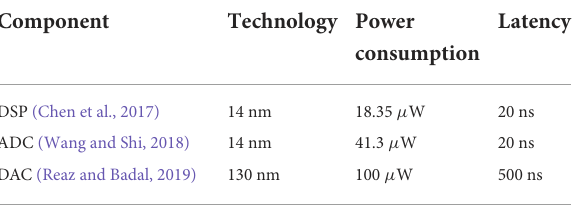
TABLE 1 Power consumption and latency features of the peripheral (digital) circuits considered for the simulations of the proposed IMC